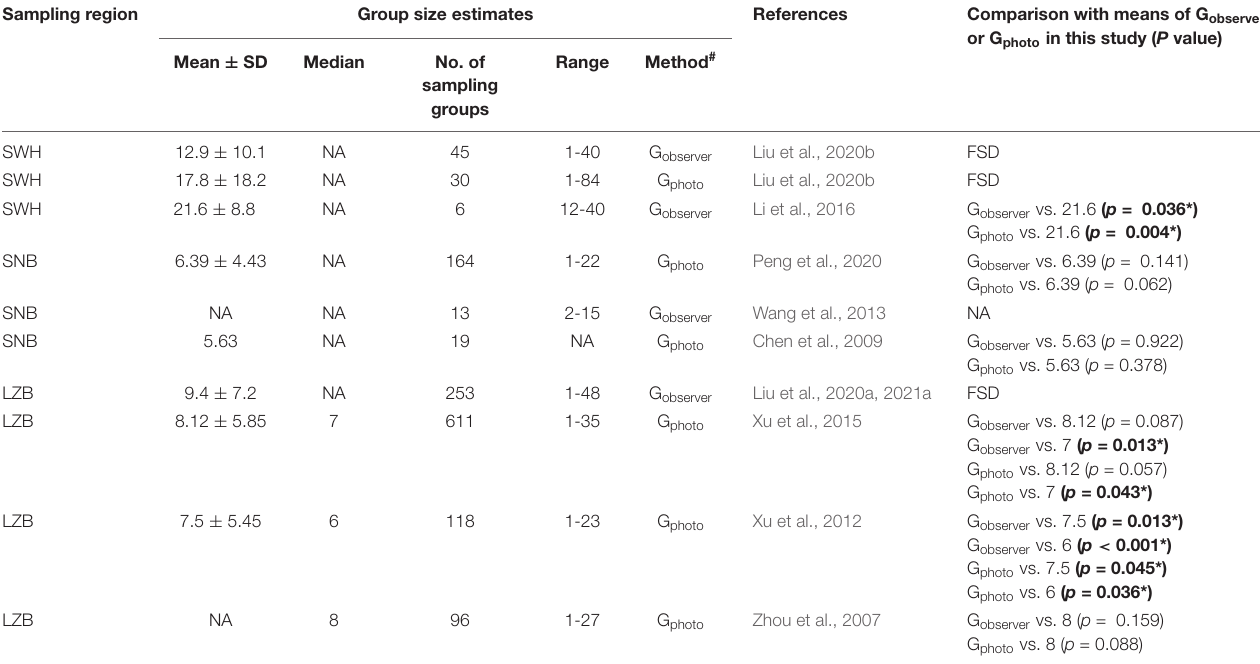
TABLE 3 | Comparisons of humpback dolphin group size obtained from different studies in three sampling regions, i.e., SWH, SNB, and LZB. Sampling